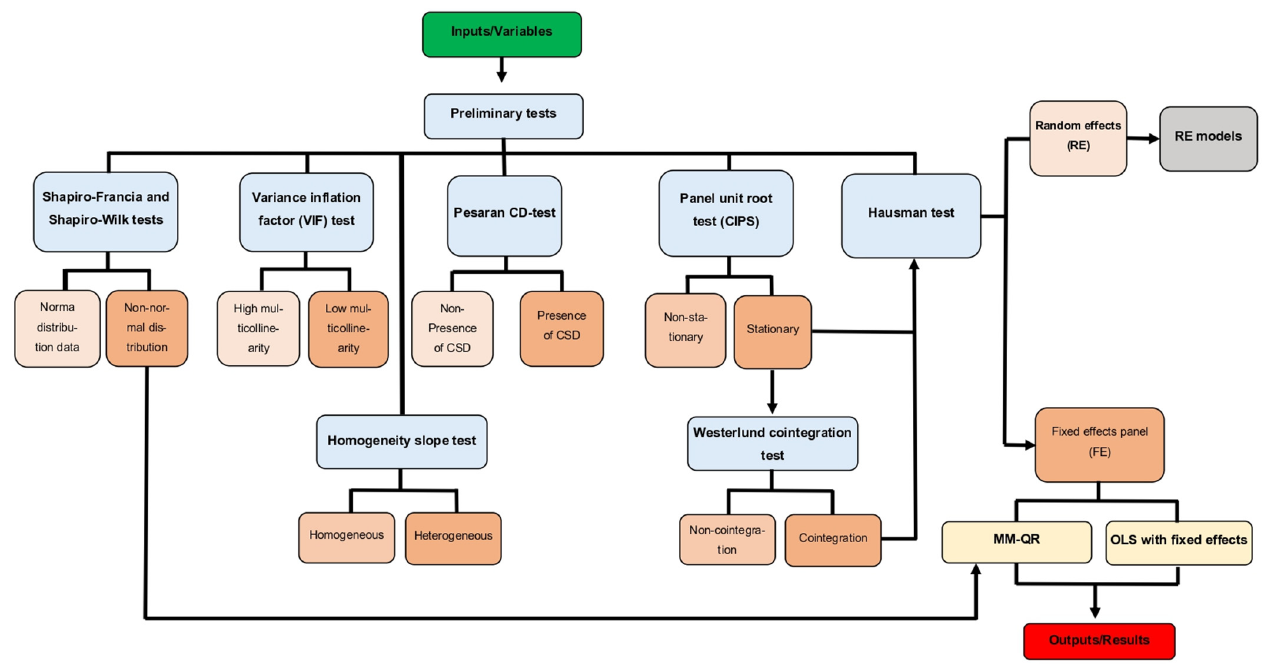
Figure 6. Methodology strategy. The authors created this figure.